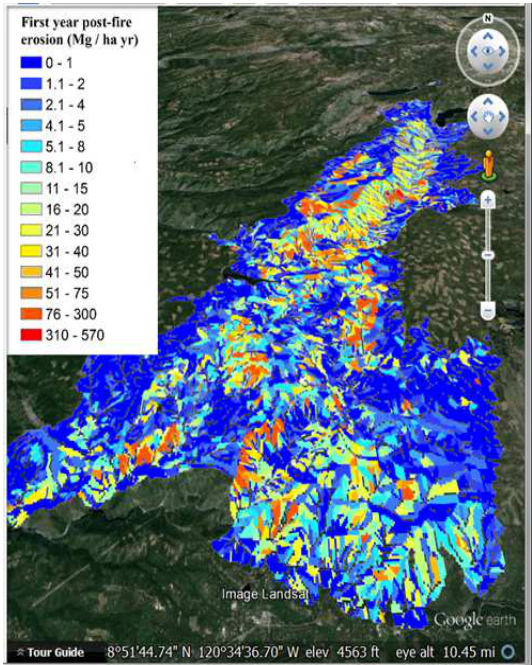
Figure 7. Post-fire hillslope erosion predictions for the King fire displayed in Google Earth.